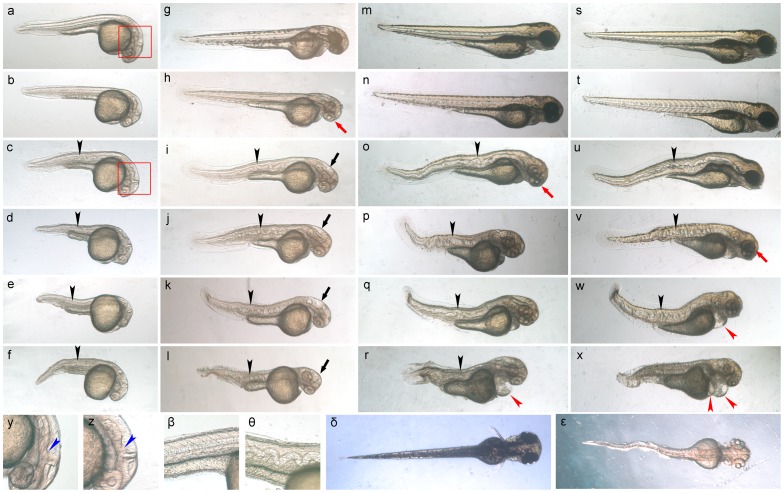
The effect of isocyanide 1 on Danio rerio (zebrafish) embryos.Zebrafish embryos were treated with isocyanide 1 at different concentrations from the early developmental stages (<2 hpf). a–f) Observed at 28 hpf. g–l) observed at 48 hpf; m–r) observed at 74 hpf; s–x) observed at 96 hpf; a,g,m,s) the control; b,h,n,t) 0.5 µg ml−1 isocyanide 1 treated; c,i,o,u) 1 µg ml−1 isocyanide 1 treated; d,j,p,v) 1.5 µg ml−1 isocyanide 1 treated; e,k,q,w) 2 µg ml−1 isocyanide 1 treated; f,l,r,x) 2.5 µg ml−1 isocyanide 1 treated. Note the “wavy” notochord (black arrowheads) and the hydrocephalus (black arrows) at concentrations ≥1 µg ml−1. Also note the pigmentation defect in the eyes (red arrows) and bodies of treated embryos. The red arrowheads point to pericardial edema, which developed under high concentrations. The rectangles in panels a and c indicate the area shown at higher magnification in panels y and z, respectively. y,z) High magnification of the embryo head at 28 hpf in the y) control and z) 1 µg ml−1 isocyanide 1, revealing abnormal development in the isocyanide 1-treated embryo (compare the structure indicated with blue arrowheads). β,θ) High magnification of the embryo notochord at 28 hpf in the β) control and θ) 1 µg ml−1 isocyanide 1, revealing a wavy notochord in the isocyanide 1-treated embryo. δ,ε) Top view of embryo at 72 hpf in the δ) control and ε) 1 µg ml−1 isocyanide 1, revealing the lateral undulation of the notochords in the isocyanide 1-treated embryo.